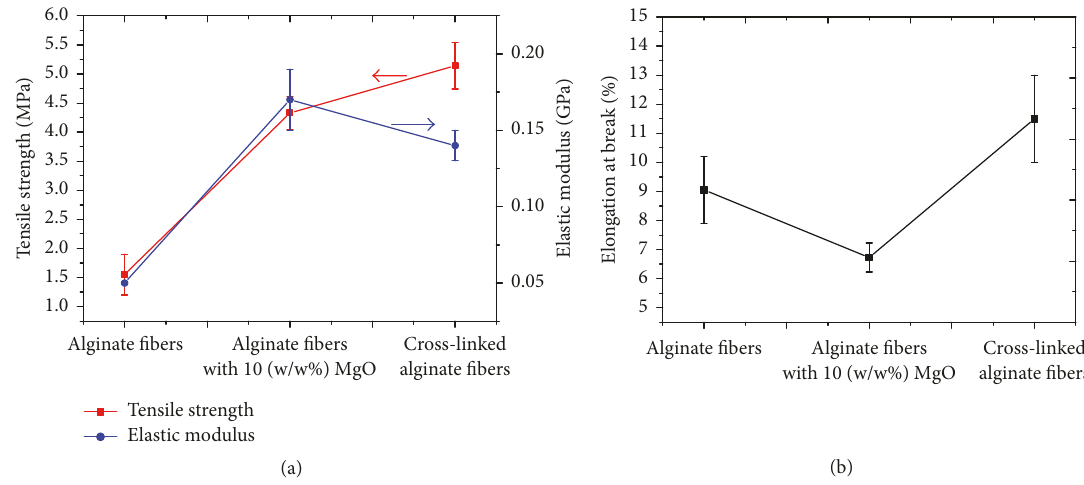
Figure 5: Plots of (a) tensile strength and elastic modulus and (b) elongation at break of electrospun alginate-based, alginate/MgO, and cross-linked alginate